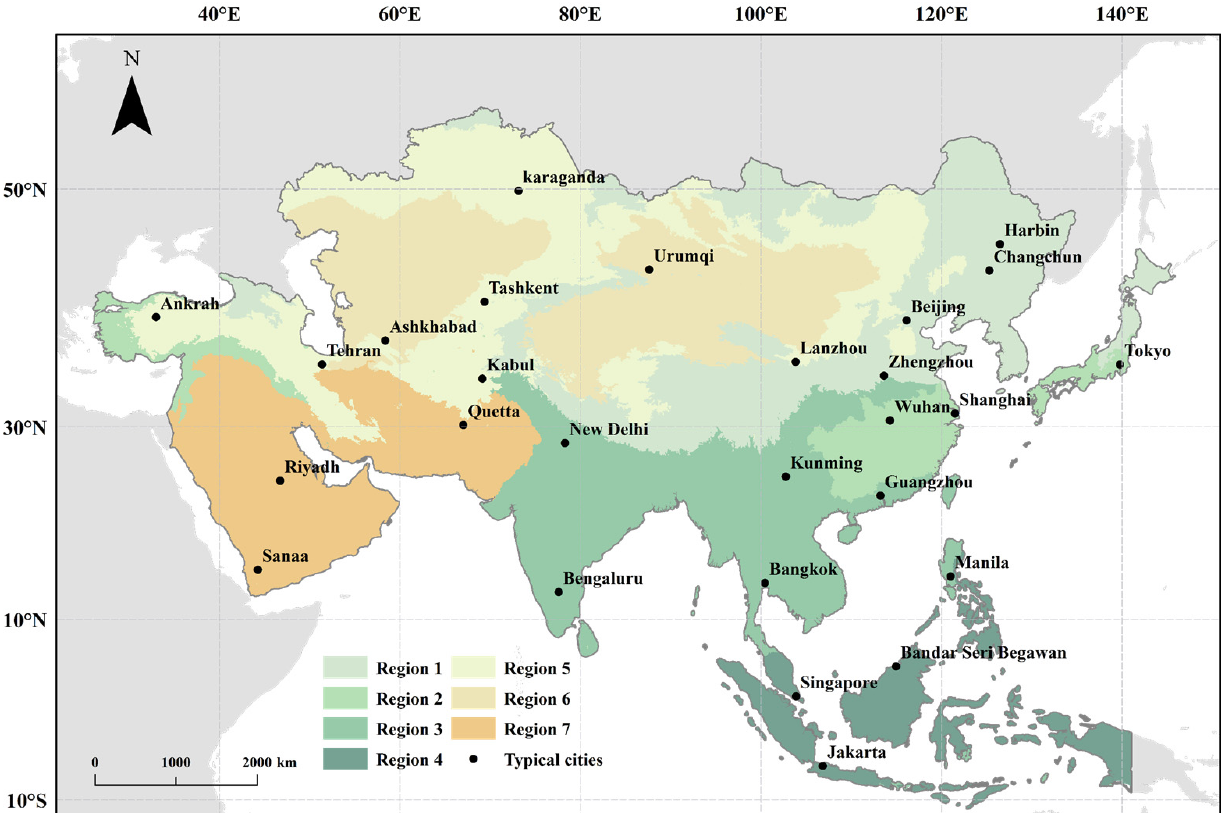
Figure 5. The map of regional divisions and typical cities in Asia.